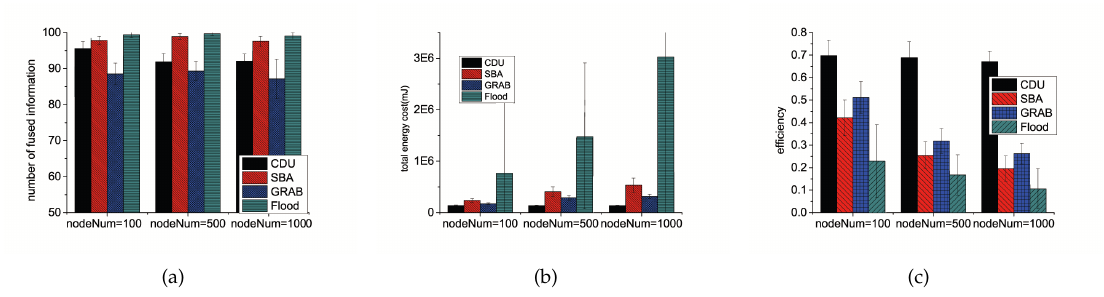
Figure 5. Experimental results with different network size using different algorithms. ( a ) introduces the comparisons of the number of fused information; ( b ) introduces the comparisons of the energy cost on communication; ( c ) introduces the comparisons of the fusion efficiency.